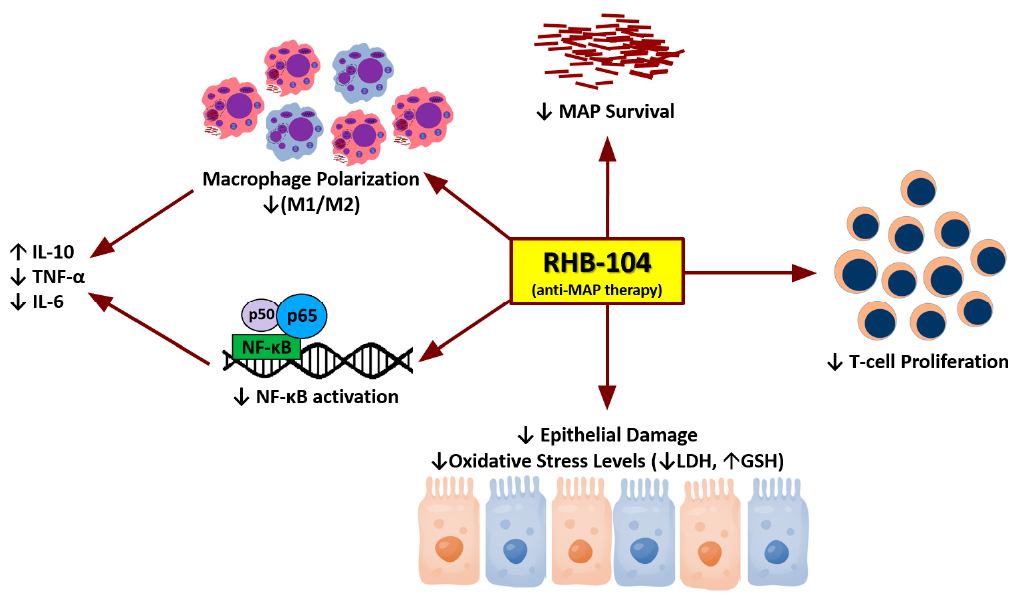
Figure 9. Schematic diagram summarizing the immunomodulatory activity of RHB-104.